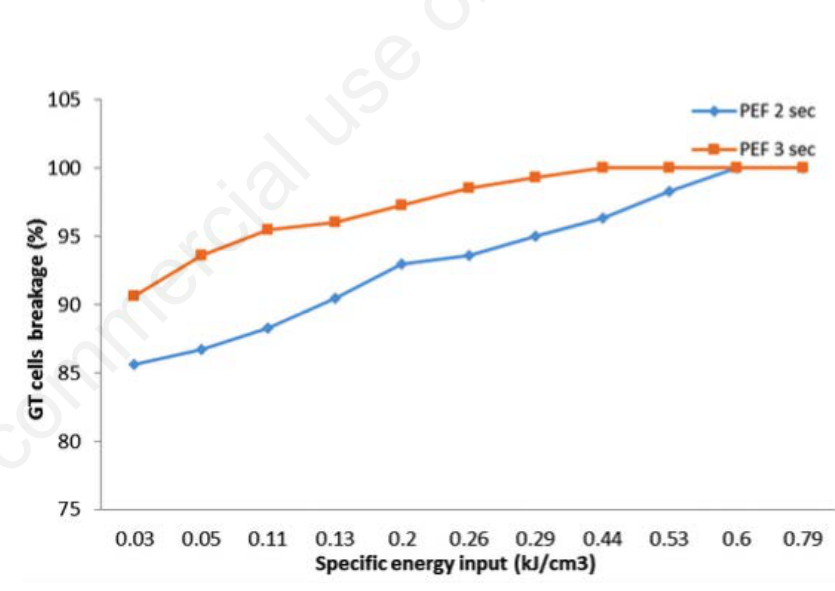
Figure 4. Influence of frequency on GT cell damage.